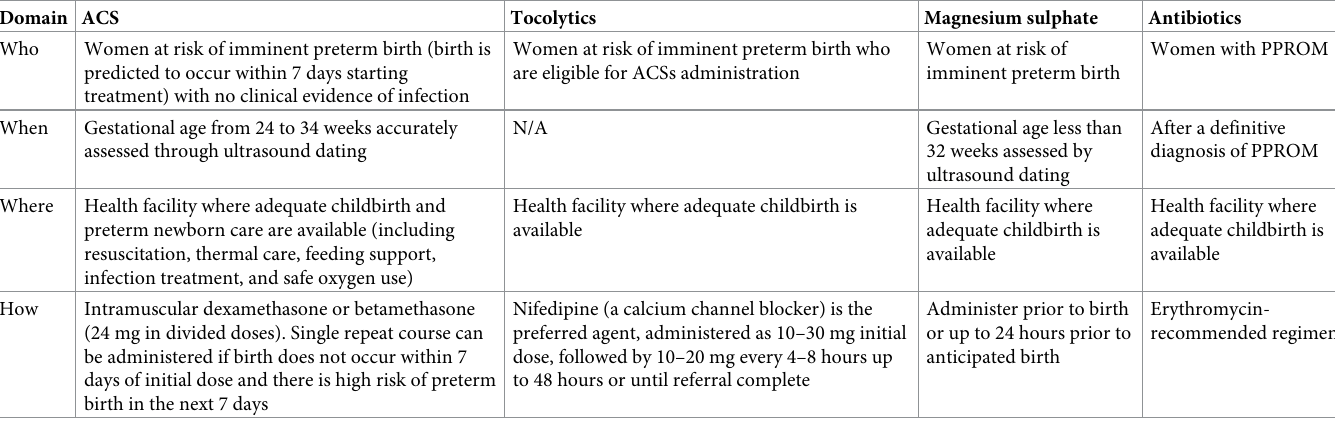
Table 1. Definition of appropriate use of interventions, based on WHO recommendations �